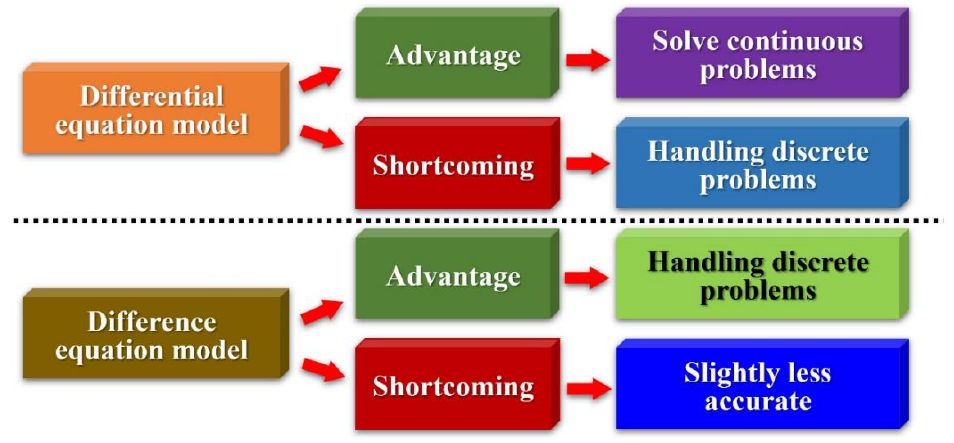
Figure 1. Comparison of differential equation models and difference equation models.